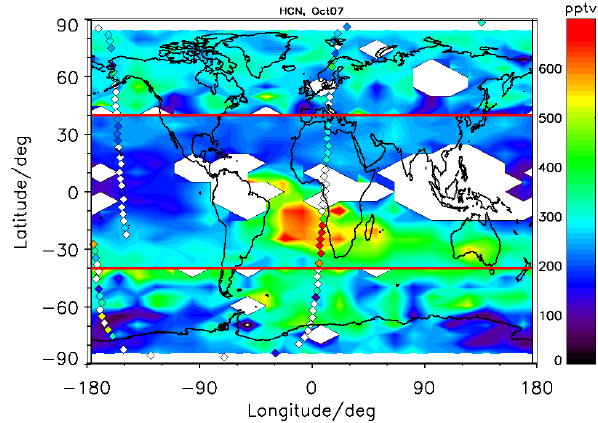
Fig. 15. As Fig. 10 but for HCN.